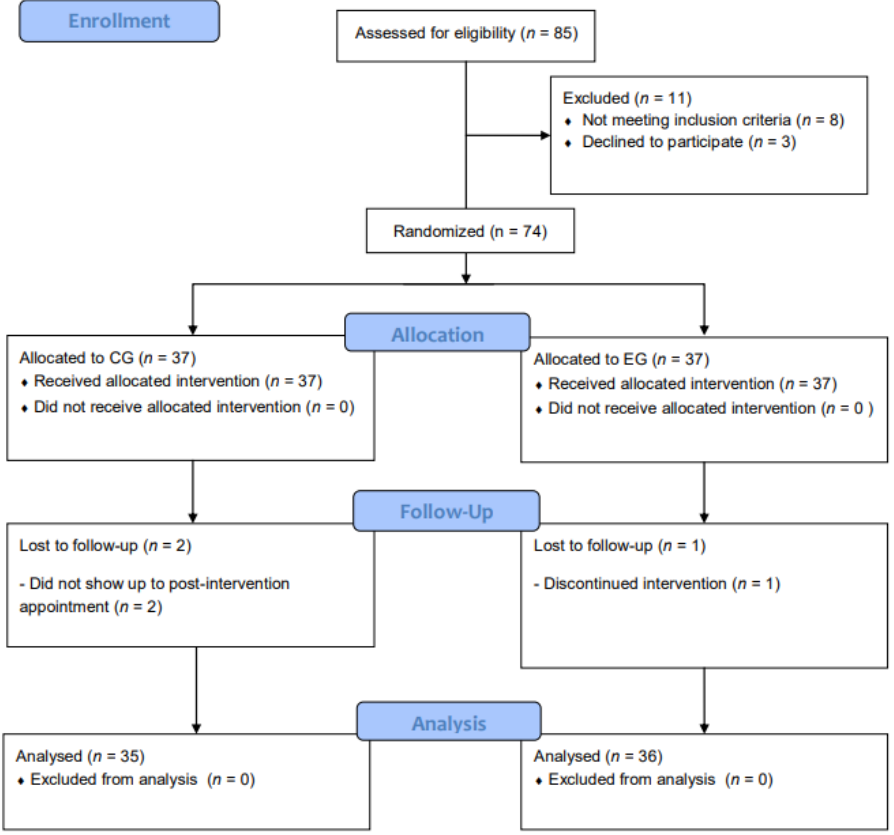
Figure 1. Flow diagram of study design.